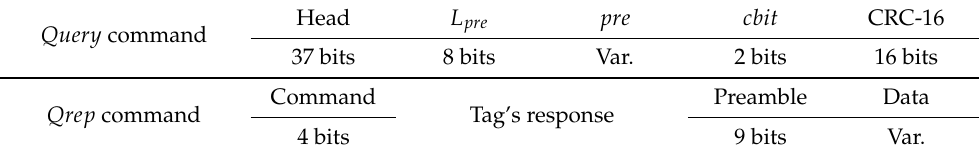
Table 2. Command and data frame